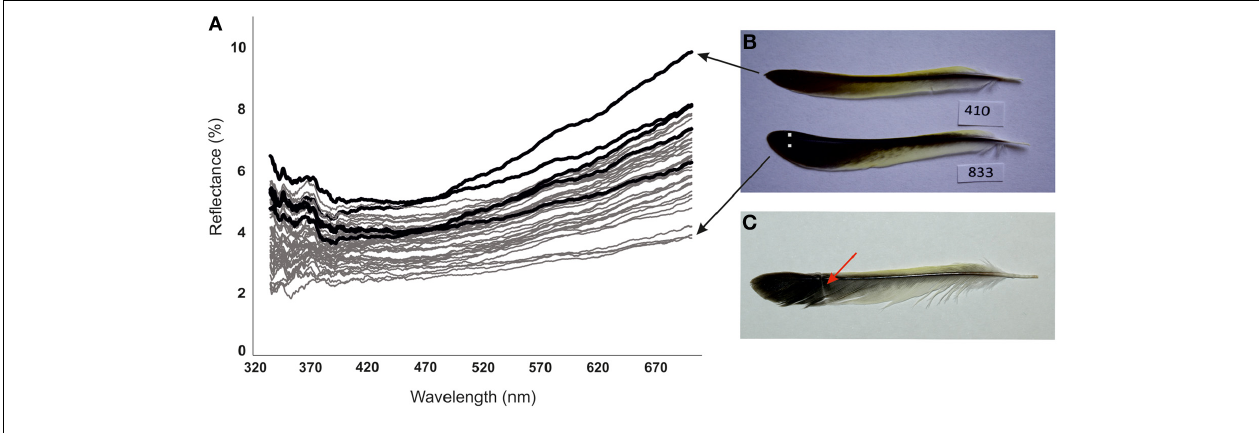
measured feathers. White dots indicate locations of color measurement. (C) Tail feather of female greenfinch with fault bar, indicated by an arrow.